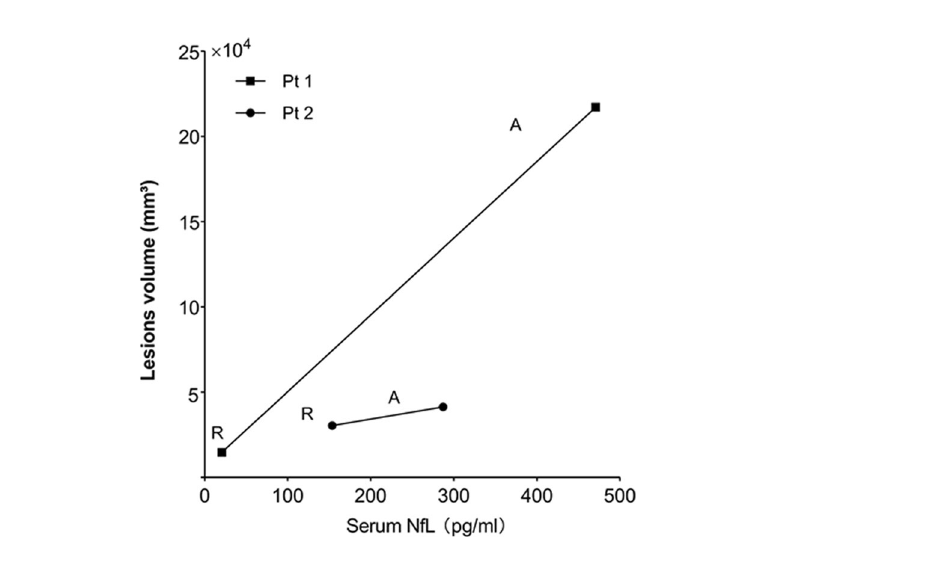
Figure 4. NfL concentration and Stroke-like lesion volume from remission phase to acute attack in two follow-up patients. NfL neurofilament light, A patients with MELAS in the acute attack, R patients with MELAS in the remission phase, Pt 1 patient 1, Pt 2 patient